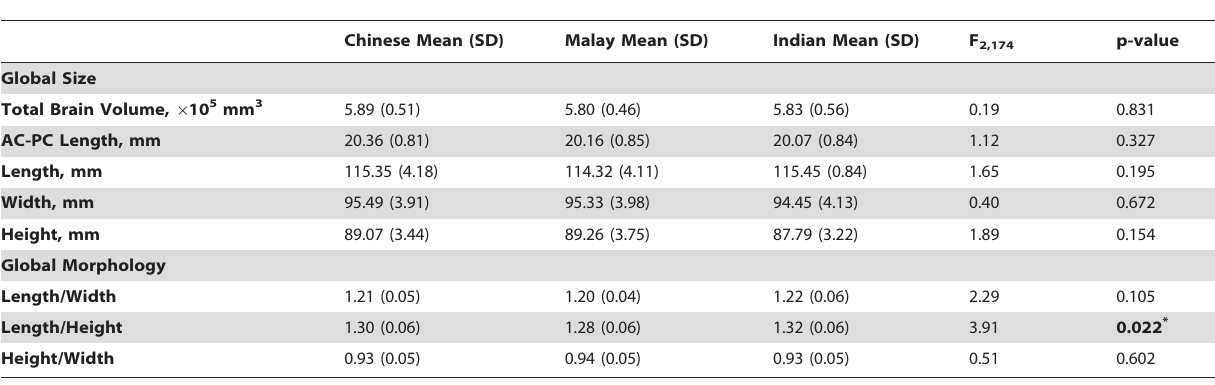
Table 2. Brain global size and morphology.